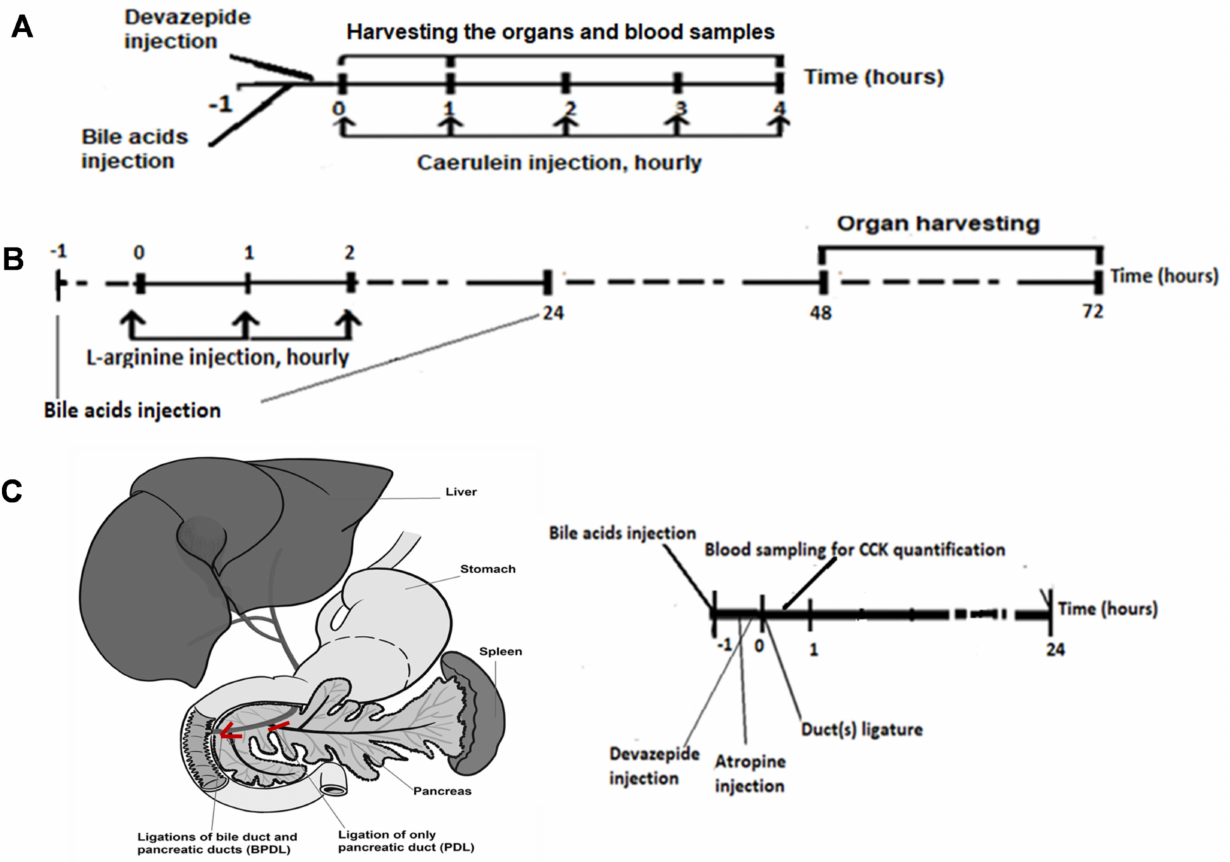
Figure 8. Animal models for AP to test the effect of systemic BAs. ( A ) Caerulein model: BAs were injected 30–60 min prior, and devazepide, if utilized, was injected 15 min before the first dose of caerulein. Caerulein was administrated hourly and intraperitoneally in a dose of 50 µ g/kg body weight. The organs were harvested at 4 h (half-life time of devazepide). ( B ) L-arginine model: BAs were added one hour before and 24 h after the first injection of L-arginine, which was injected intraperitoneally (total dose 10 g/kg body weight), divided to three injections hourly. The mice